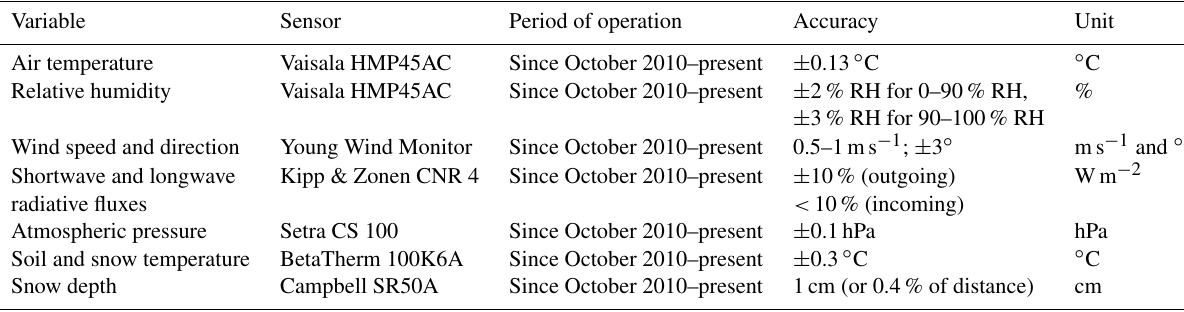
Table 2. Weather and snow variables recorded by the sensors installed at the station Hintereisferner (3026ma.s.l., 46.79867 ◦ N, 10.76042 ◦ E) in 2010, 2011 and 2012. Accuracy according to technical data sheets of the manufacturers. Original temporal resolution of the data records is 10min.